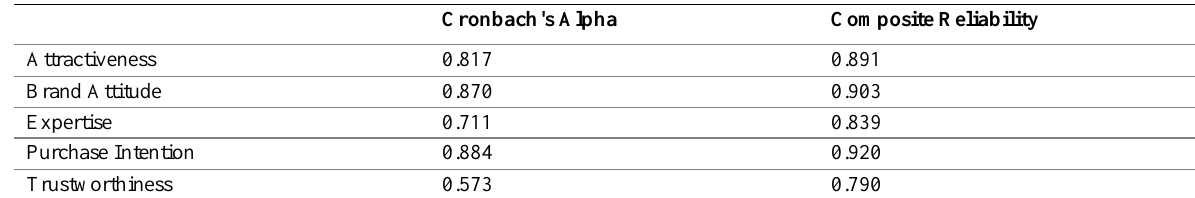
Table 2: Composite Reliability and Cronbach’s alpha